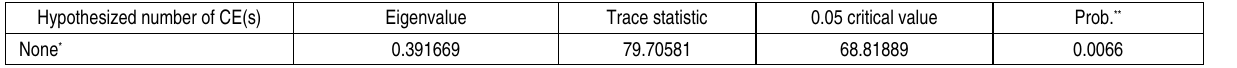
Table 3. Unrestricted cointegration rank tests (trace)